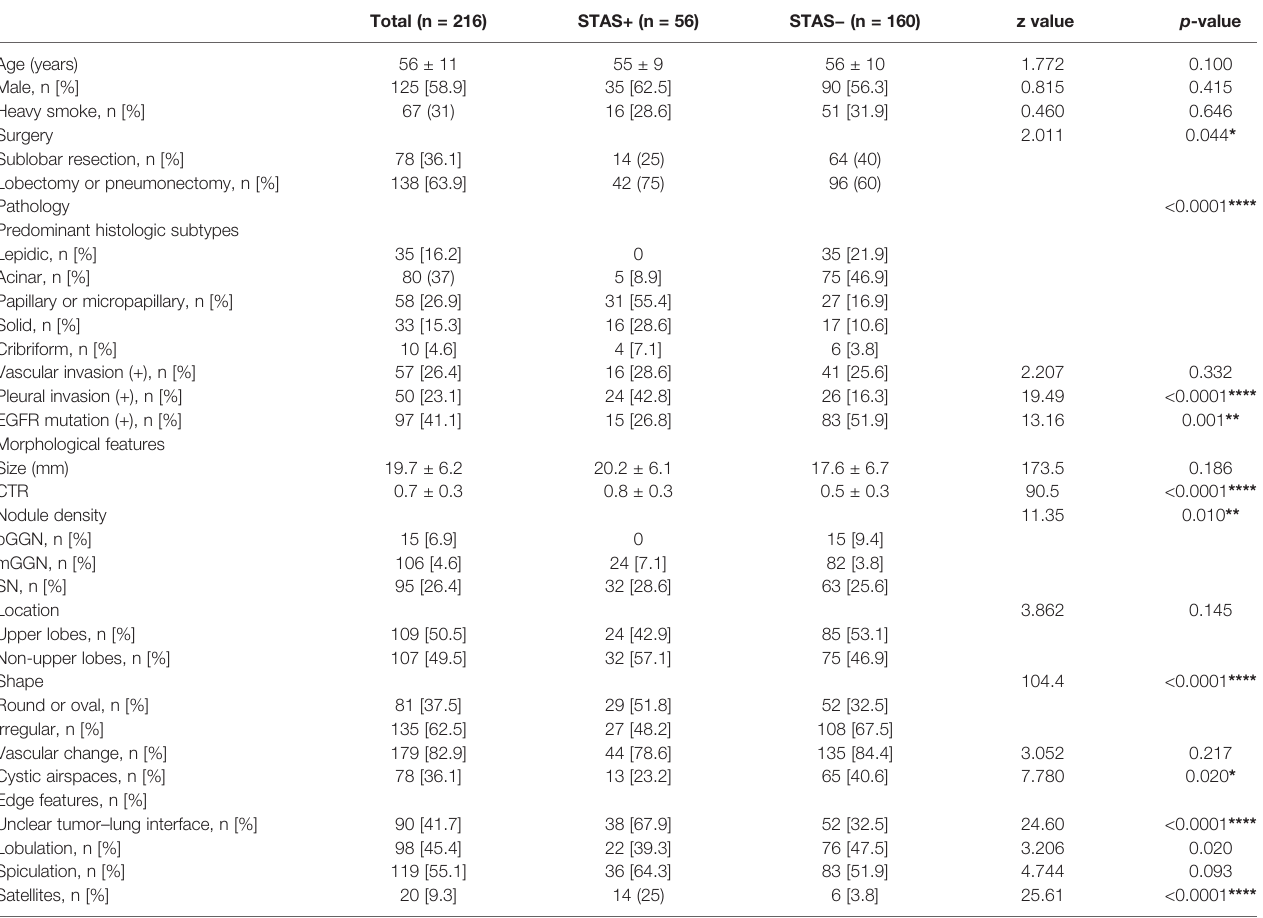
TABLE 1 | The basic clinical data and CT morphological characteristics of the two